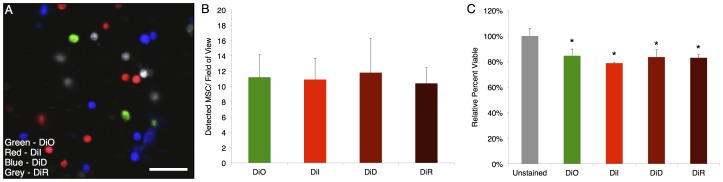
MSC staining in vitro.In vitro imaging characteristics of MSCs stained with lipophilic membrane dyes (a). Mixing equal quantities of the cells yielded similar levels of detected cells (b). Despite a small decrease in viability from the unstained control (p<0.05, Tukey’s HSD), there was minimal difference between viability of cells after staining as measured by MTS (c). Scale bar = 100 µm.